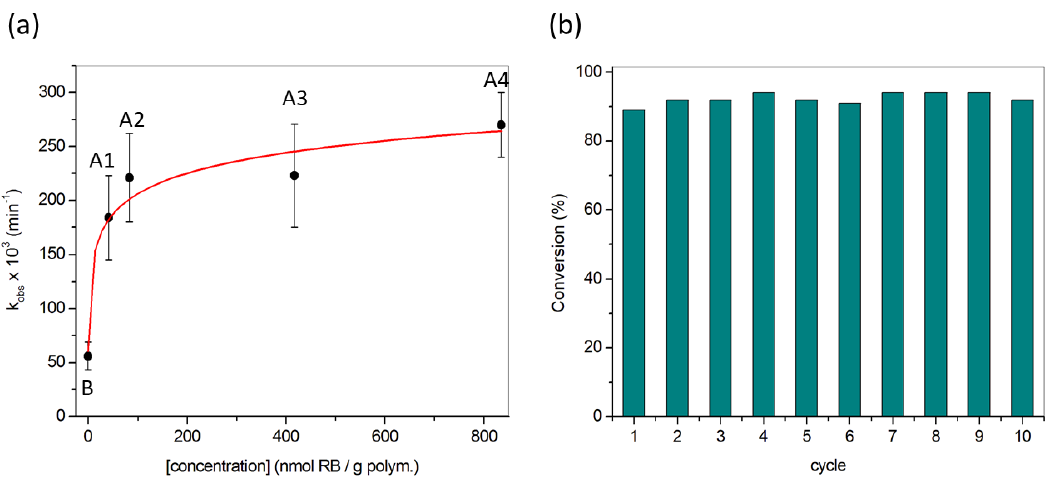
Figure 7. ( a ) Observed kinetic constants of the reaction between DMA and 1 O 2 generated by irradiated polymers A1 – A4 , B ; ( b ) Conversion yield of the reaction between DMA and 1 O 2 generated by the same sample of irradiated polymer A4 (see text for details) during 10 cycles.